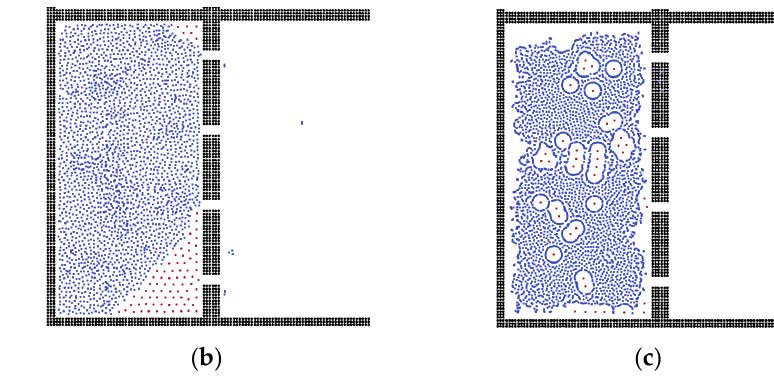
Figure 8. Results of separation with different oil viscosities: ( a ) 0.2 mPa·s; ( b ) 0.4 mPa·s; ( c ) 0.8 mPa·s.